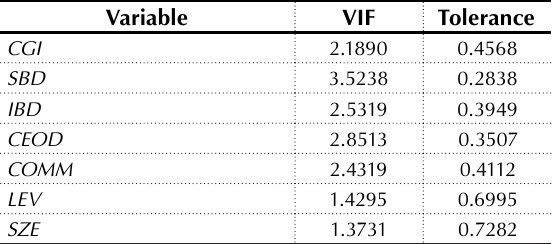
Table 4. Results of multicollinearity test